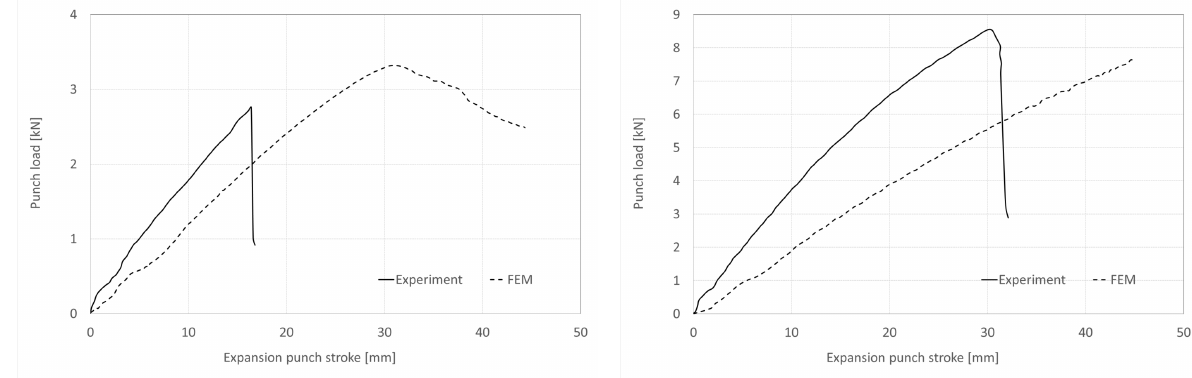
Figure 9: Punch force during expansion operation for AA5352 (left) and TH330 sheets (right)